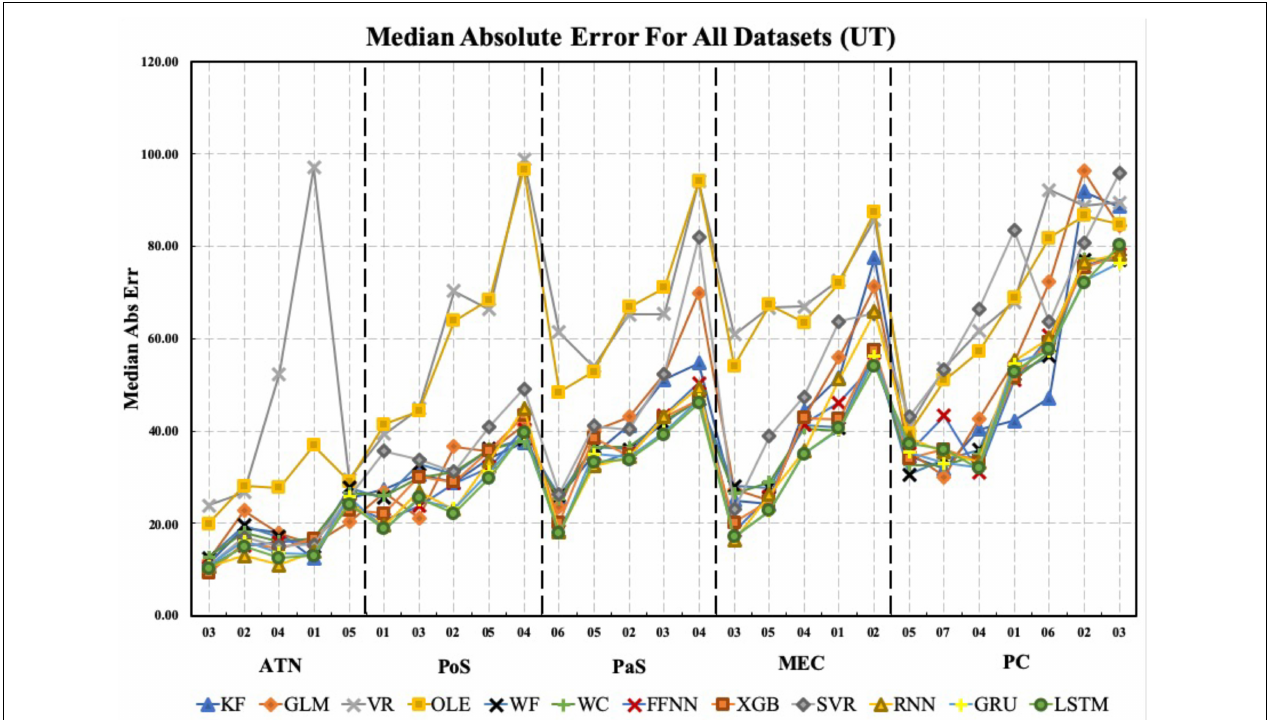
FIGURE 7 | The median absolute error is shown for each brain region, each dataset, and each decoding method. Datasets for each brain region are sorted from lowest to highest median absolute error (i.e., from best to worst decoding accuracy). Note that median absolute error varies considerably within regions and on average increases from ATN to parahippocampal and PC regions. KF, Kalman Filter; GLM, Generalized Linear Model; VR, Vector Reconstruction; OLE, Optimal Linear Estimator; WF, Wiener Filter; WC, Wiener Cascade; SVR, Support Vector Regression; XGB, XGBoost; FFNN, Feedforward Neural Network; RNN, Recurrent Neural Network; GRU, Gated Recurrent Unit; LSTM, Long Short-Term Memory.